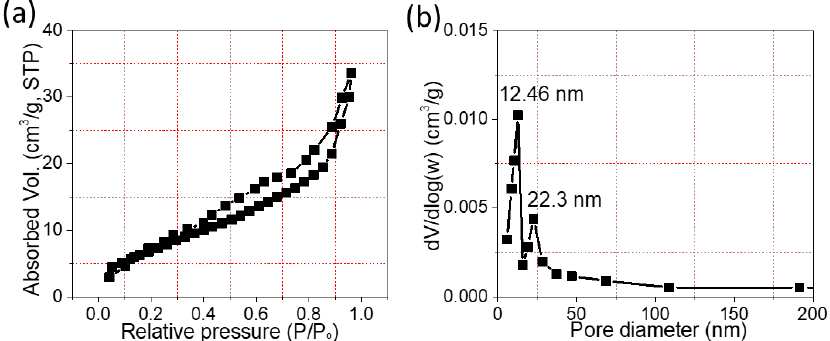
Figure 5. ( a ) The N 2 sorption isotherms of MnO 2 -NPs. ( b ) BJH profile of the pore size distribution.